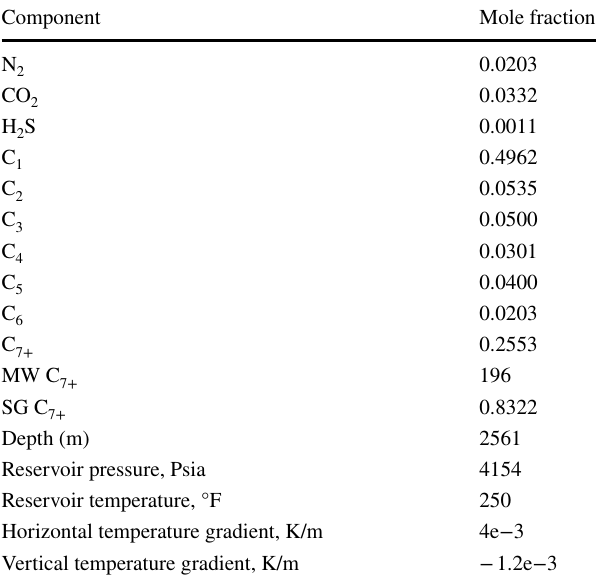
Table 3 Volatile oil sample, reference point values, reported by